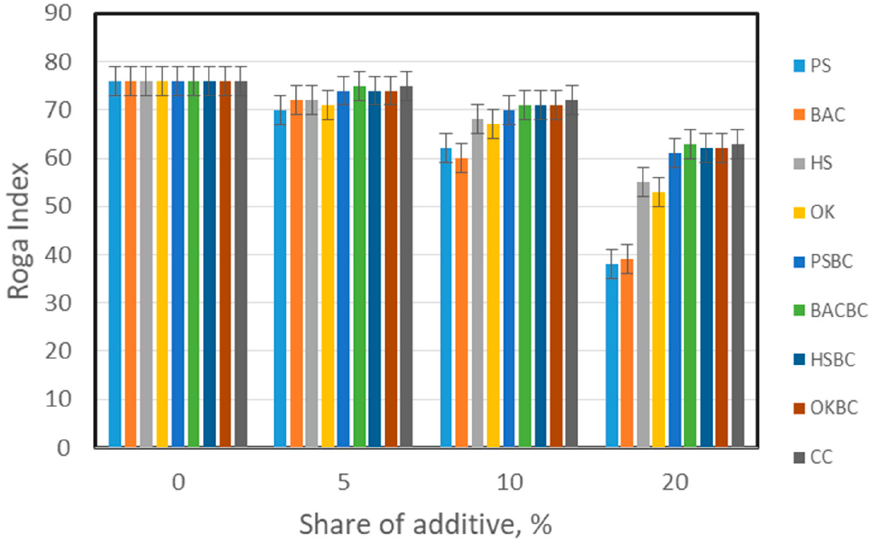
Figure 7. Influence of type and share of bio-components on Roga Index.